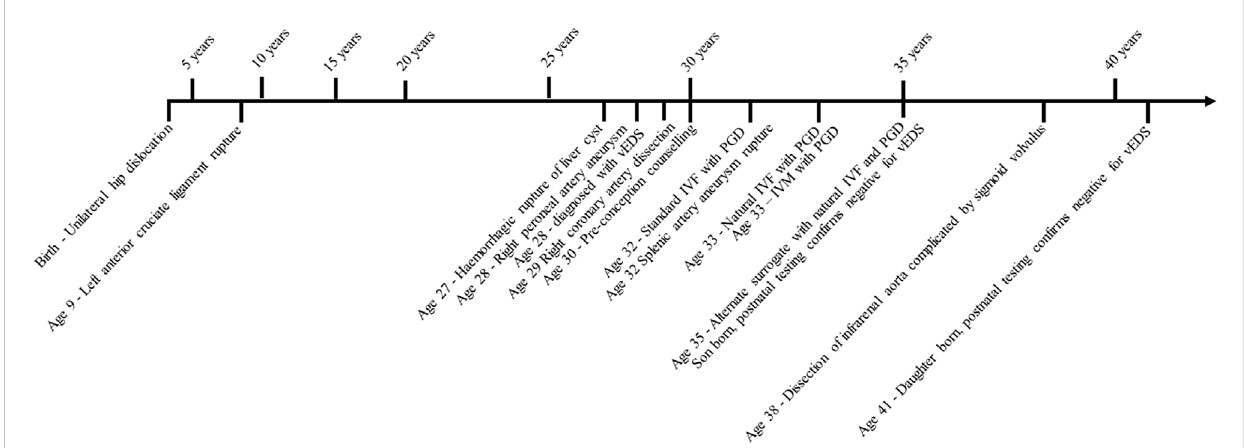
FIGURE 1 Timeline of clinical events recorded in the proband. IVF, in vitro fertilization; IVM, — in vitro maturation; vEDS, — vascular Ehlers – Danlos syndrome; PGD, — pre-implantation genetic diagnosis. Implantation and births via